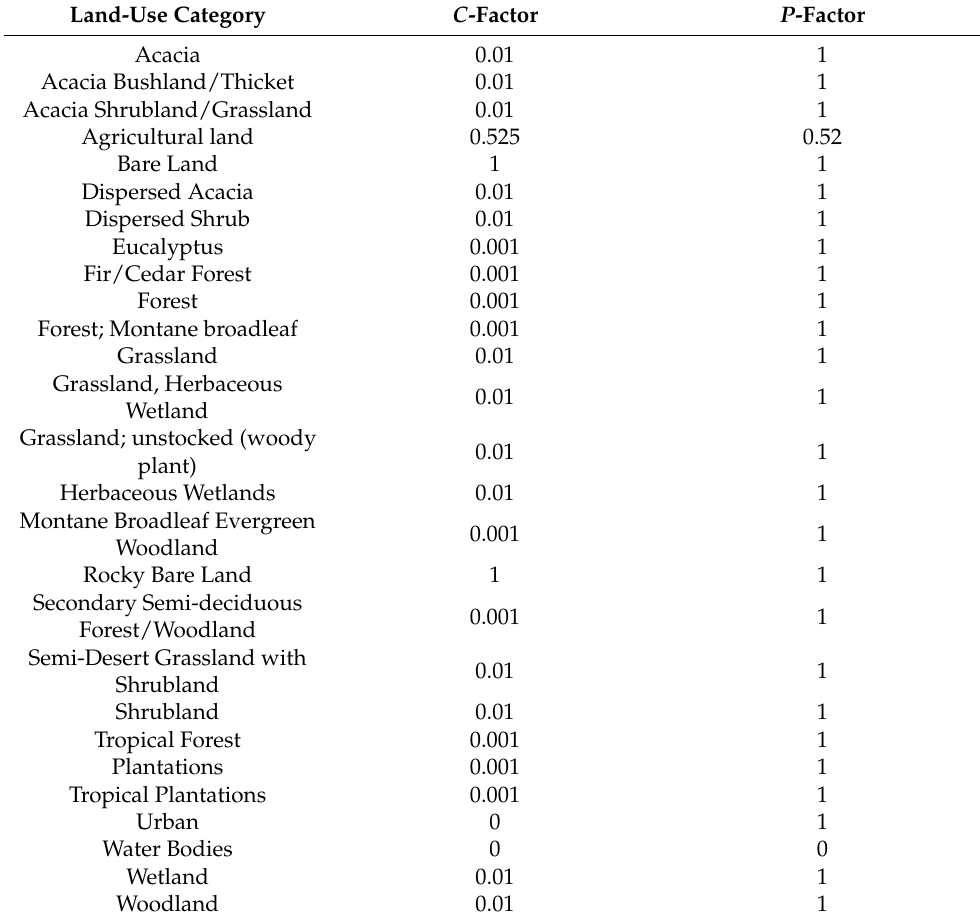
Table 1. The assigned cover and conservation practice factors for each land use of the watersheds under our